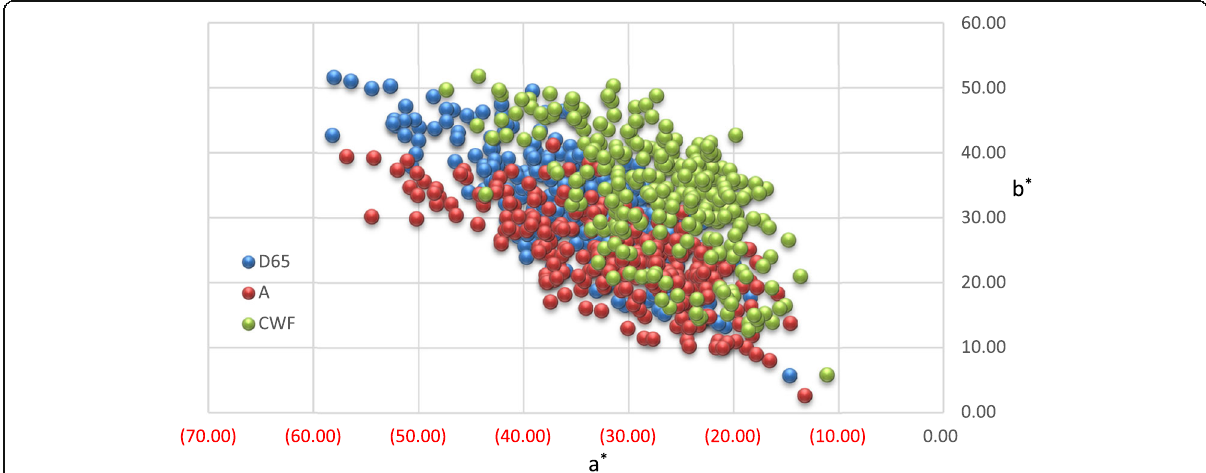
Fig. 1 Chromatic plots of Jadeite-Jade ’ s green under three standard lighting sources based on the CIE 1976 L*a*b* uniform color